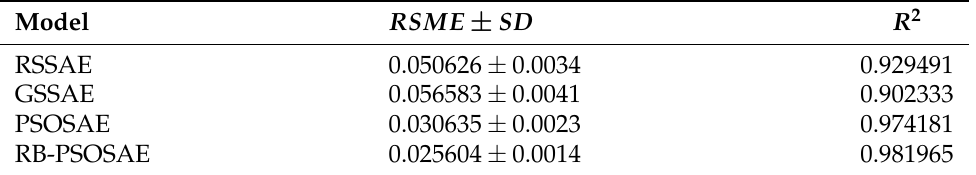
Table 2. Prediction performance of debutanizer column soft-sensor models.